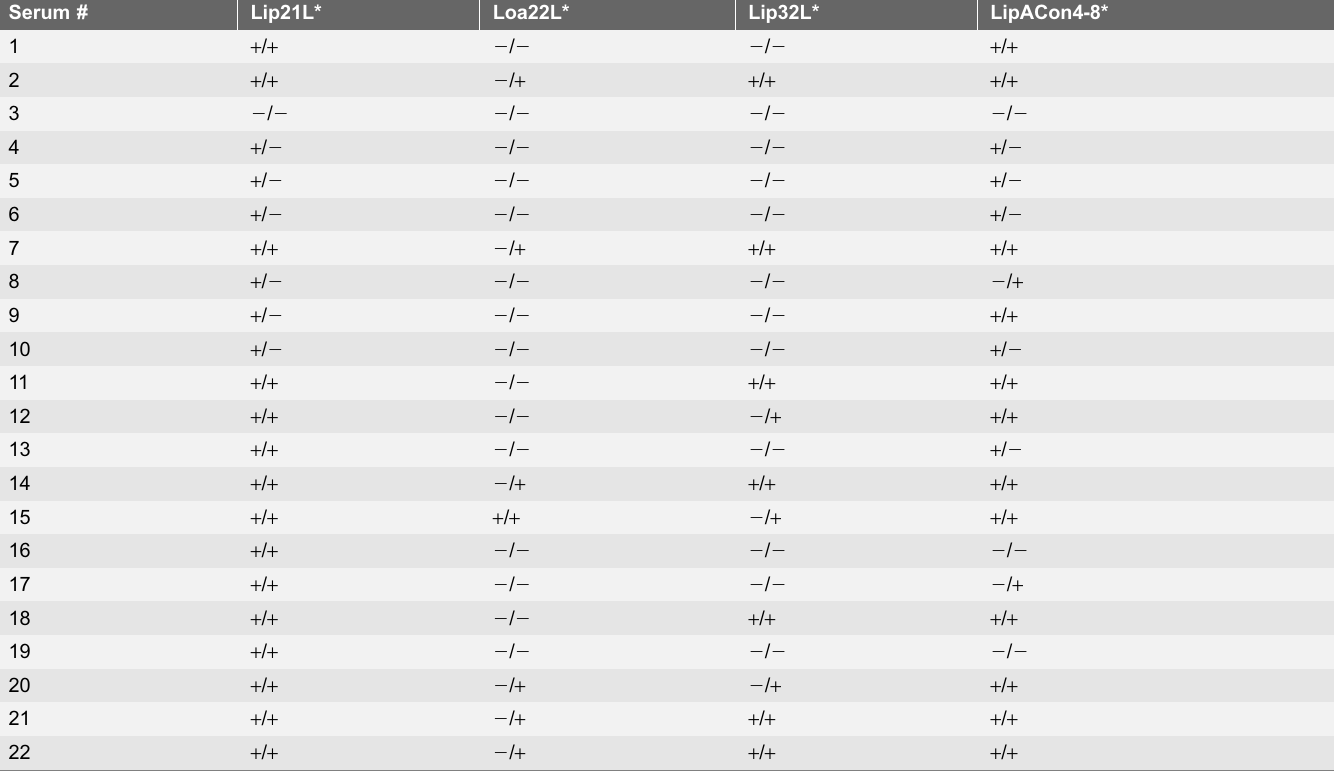
Table 7. The ELISA and Western blot analysis of the 22 samples that were MAT positive, but ELISA negative to at least one to four of these